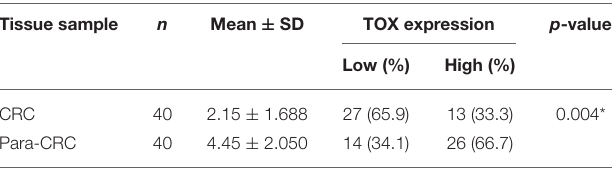
TABLE 2 | Correlation between TOX expression and clinicopathological features were analyzed by chi-square test, adjusted chi-square test, or Fisher’s exact test. Clinicopathological